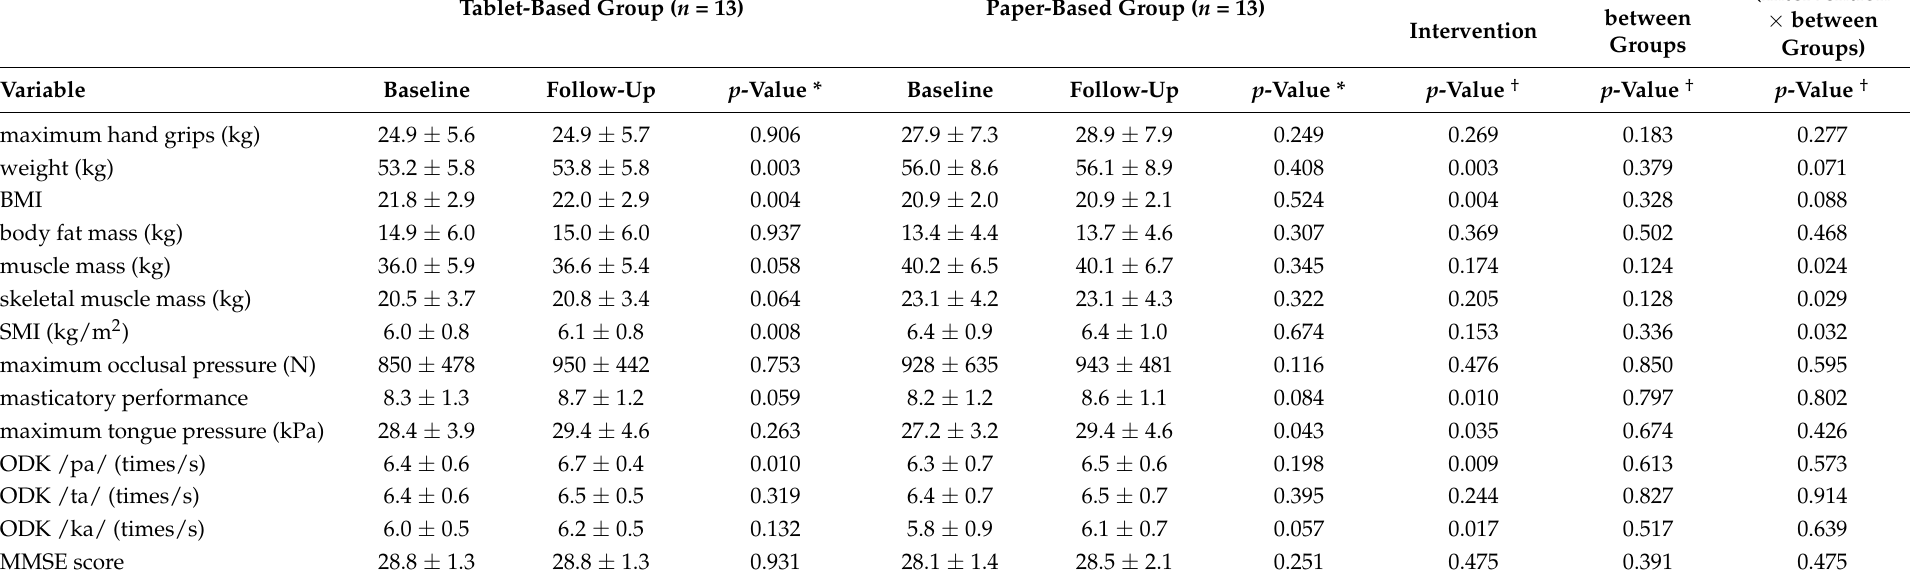
Table 3. Comparison of the tablet- and paper-based groups at the baseline and